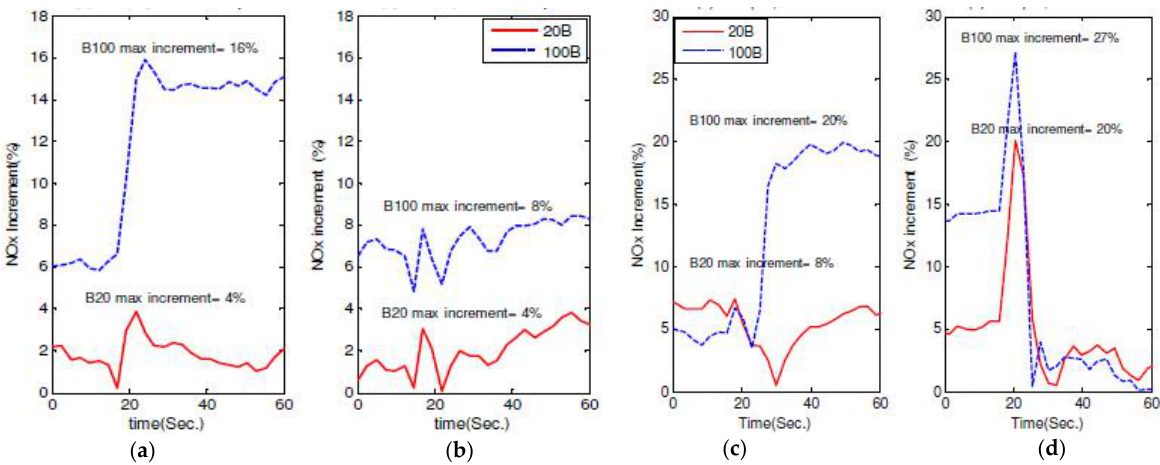
Figure 14. Variation of NOx emission percentage reduction of CI engine with time with the biodiesel blend fuels during ( a ) positive and ( b ) negative speed transients of between 1000 and 1500 rpm. Variation of NOx emission percentage reduction in the CI engine running with the different biodiesel blends during ( c ) positive and ( d ) negative torque transient conditions.